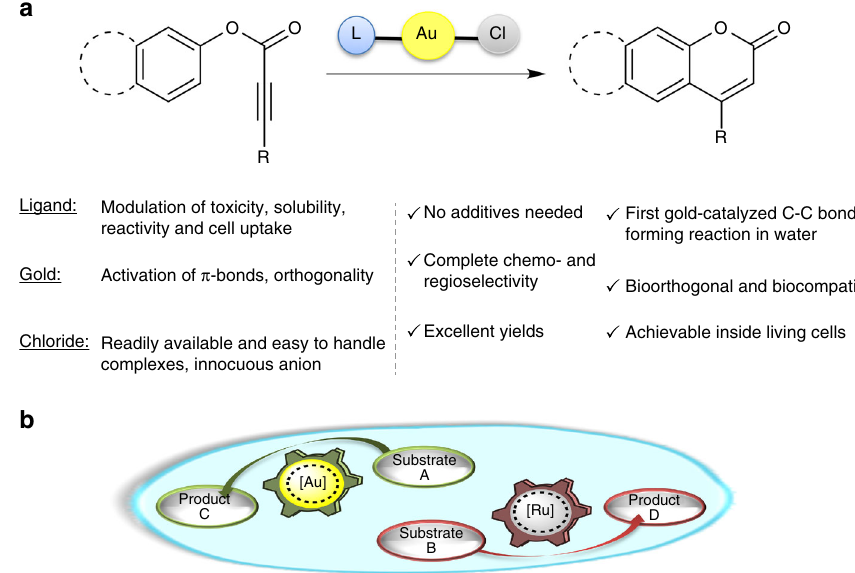
Fig. 1 Au(I)-promoted cyclization and intracellular transformations. a Gold-chloride complexes as ligand-tuned, water-activatable precatalysts, and proposed gold-promoted carbocyclization. b Mutually orthogonal, and bioorthogonal, gold and ruthenium catalysis inside living